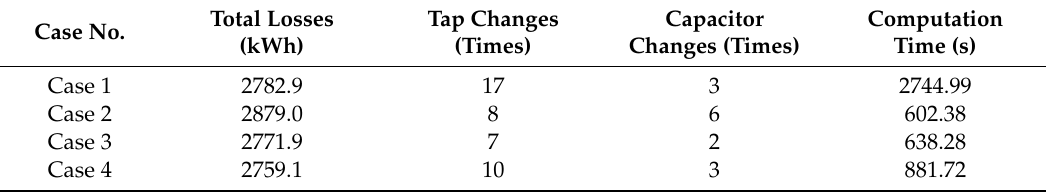
Table 2. Network losses, device adjustment times and time consumed by cases 1 to 4. Case